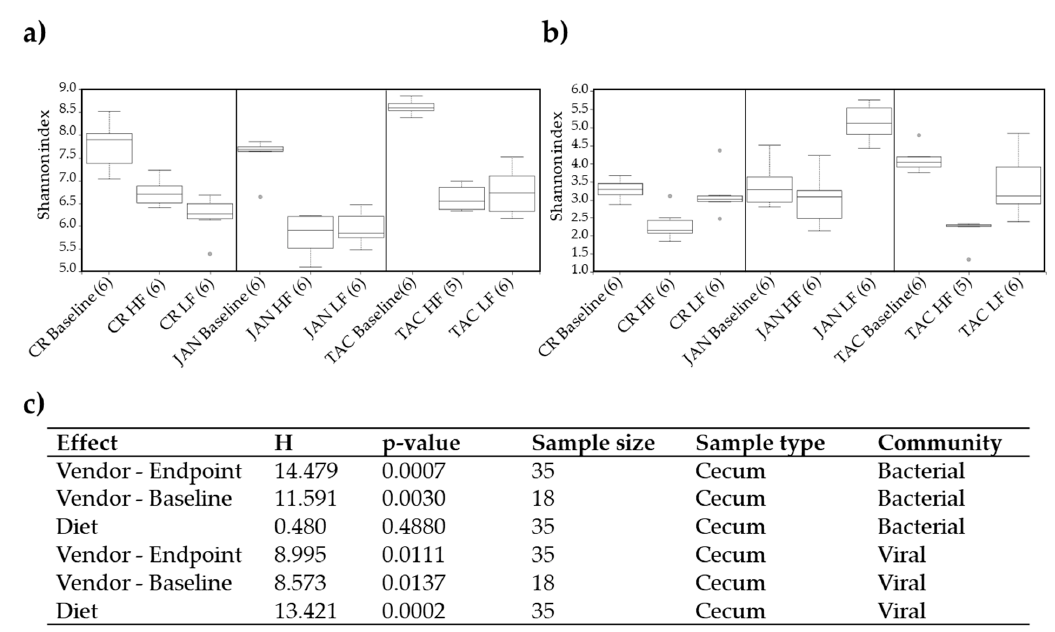
Figure 2. Shannon index of the caecal ( a ) bacterial and ( b ) viral community at baseline (five weeks of age) and after 13 weeks on low-fat or high-fat diet (18 weeks of age), respectively. The parentheses show the number of samples from each group included in the plot and grey dots indicate outliers. ( c ) Kruskal–Wallis group analysis of the Shannon diversity index of the effects of diet and vendor at baseline and endpoint. LF = low-fat diet, HF = high-fat diet, CR = Charles River, JAN = Janvier, TAC = Taconic.